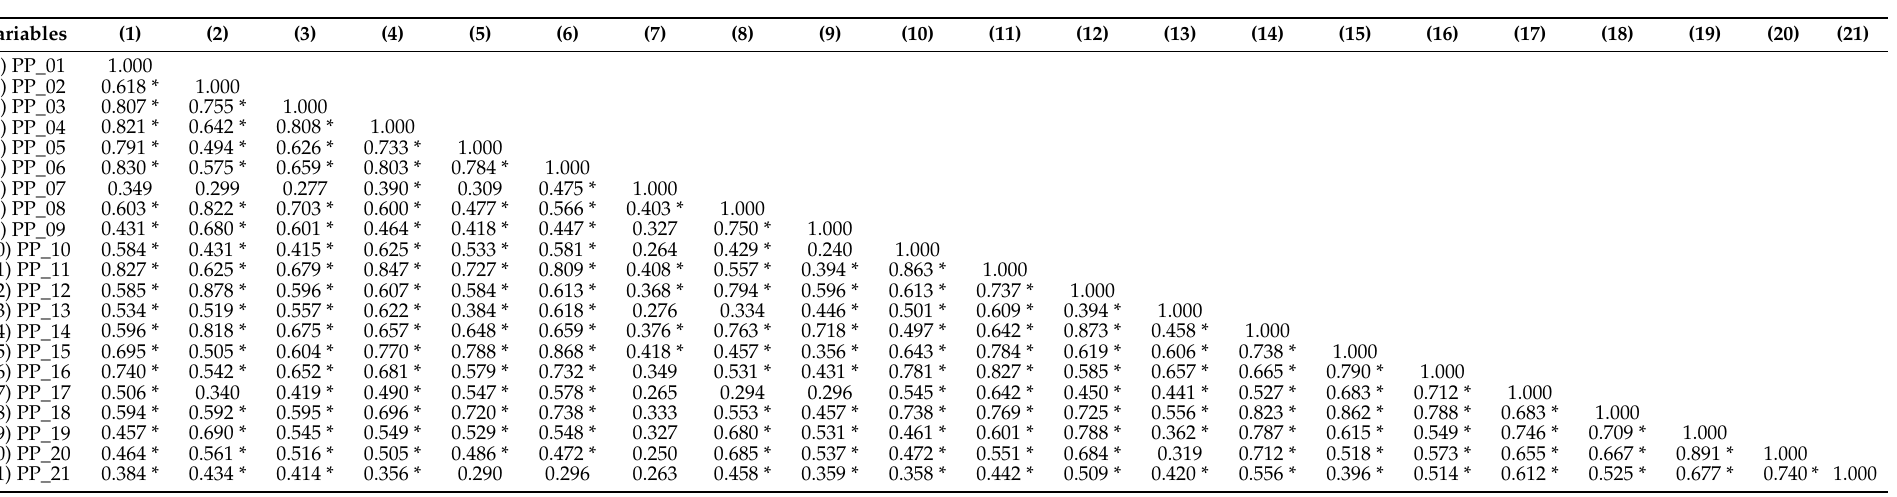
Table 16. Pearson correlations by pedagogical practices’